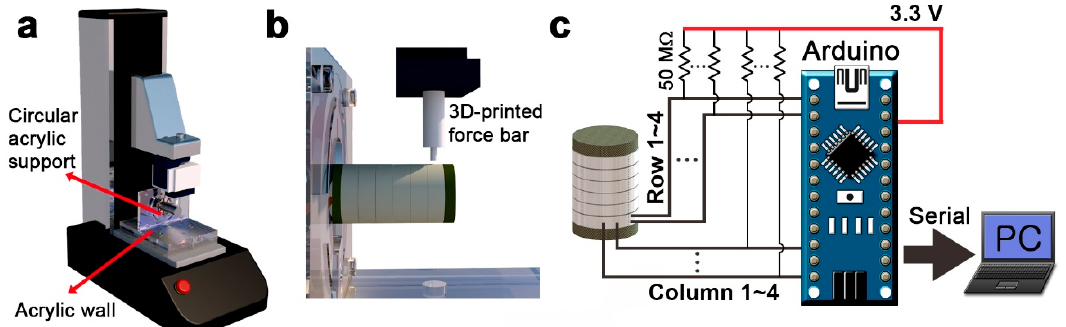
Figure 9. Schematic of the experimental setup. ( a ) Schematic of the tensile testing setup with the sensor using ( b ) a 3-D-printed force bar. ( c ) Schematic of the sensing system in real